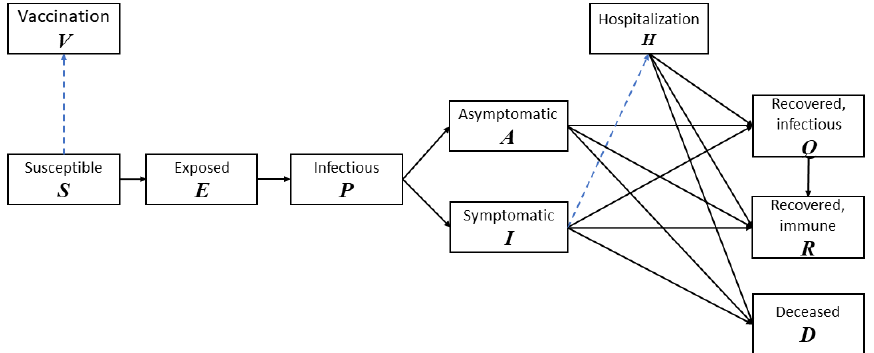
Figure 1. The stage transition diagram of our COVID-19 model. Solid lines are transitions associated with new infections and disease propagation. Dashed lines are transitions associated with vaccination and treatment.